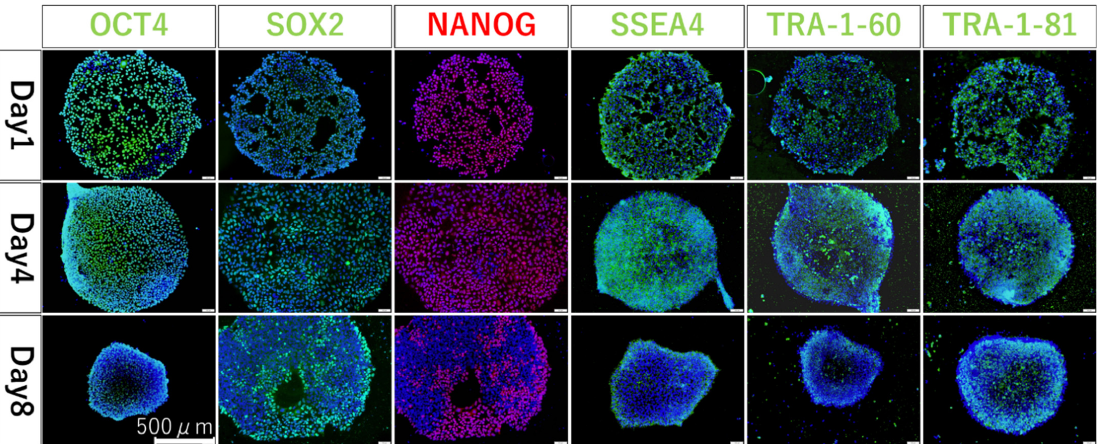
Figure 5. Fluorescent immunostaining results at 1, 4, and 8 days after seeding. Blue coloration shows where cell localize and emit green (OCT4, SOX2, SSEA4, TRA1 ‐ 60, and TRA ‐ 1 ‐ 81) or red (NANOG) depending on the localization of each protein. where cell localize and emit green (OCT4, SOX2, SSEA4, TRA1-60, and TRA-1-81) or red (NANOG)